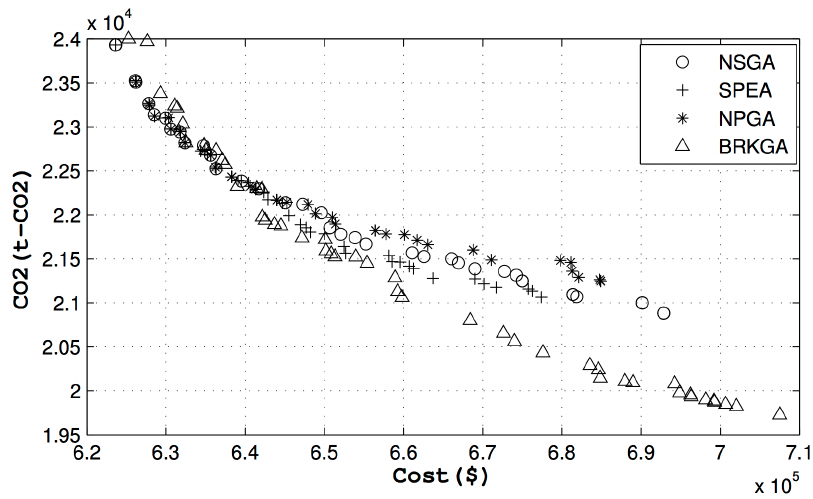
Figure 2. Pareto-optimal fronts obtained from different algorithms in a single run for 10